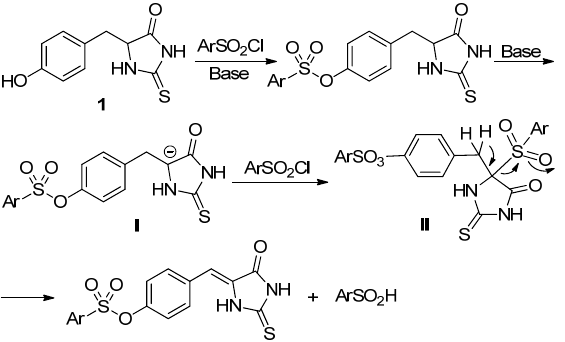
Figure 2. The proposed reaction mechanism of 5-arylidene